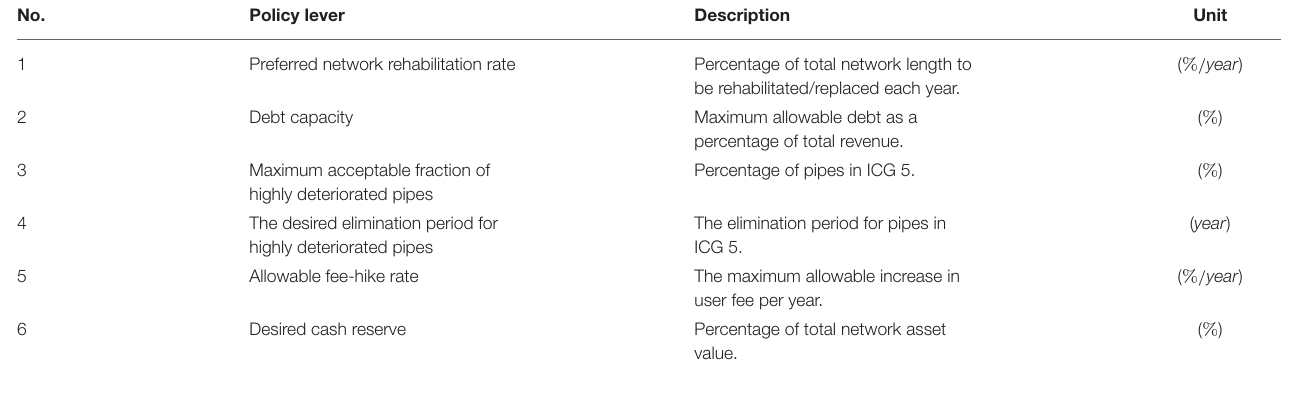
TABLE 3 | Policy levers for asset management strategy of the wastewater collection network.